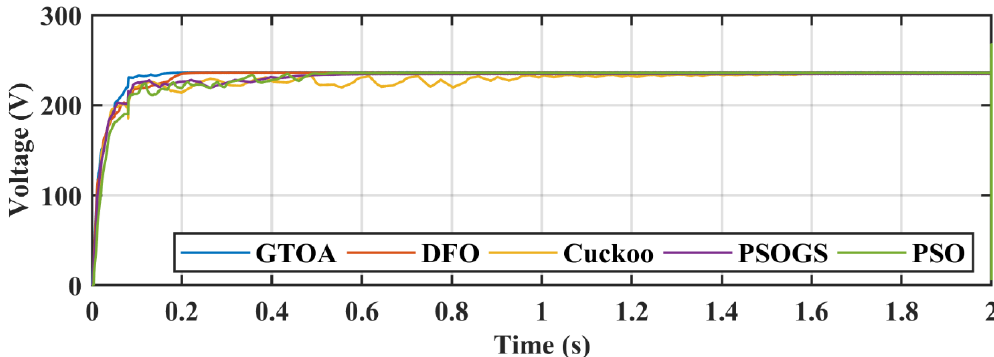
Figure 24. Zoomed-in comparison of duty cycle of GTOA.